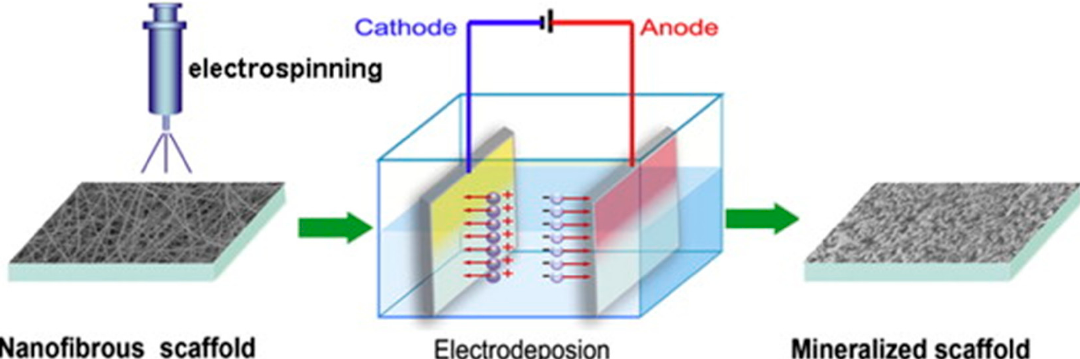
Figure 9. Experimental setup to obtain mineralized nanofibers by combining electrospinning and electrodeposition methods. The blue inset shows an SEM micrograph of a mineralized PLLA matrix prepared by electrodeposition at 3 V and 60 °C for 60 min. Reproduced with permission from [100].